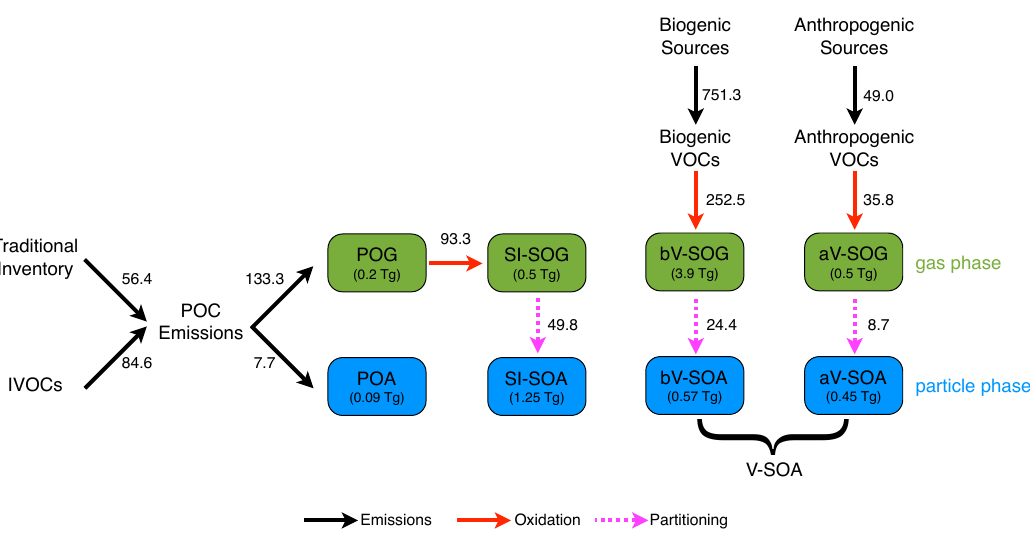
Fig. 6. Schematic showing annual production (arrows, Tgyr − 1 ) and burdens (textboxes, Tg) for the gas and particle phase classes of organic aerosol predicted by the BASE